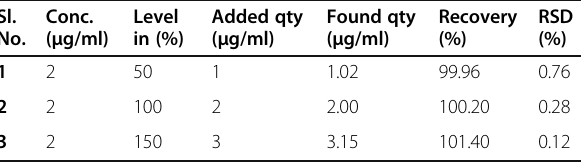
Accuracy and precision The obtained results are expressed in Tables 3, 4, and 5. The intra-day precision for apigenin was between 0.11